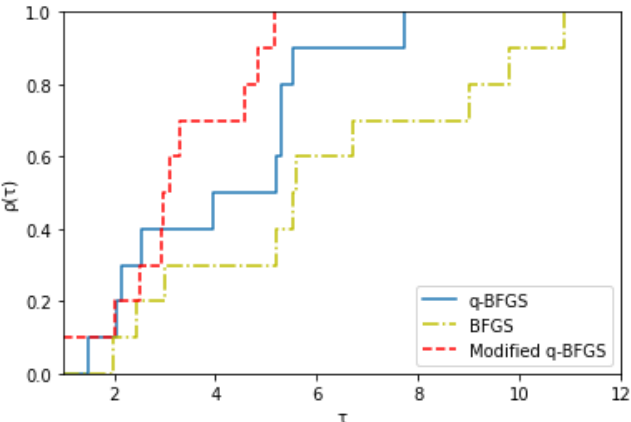
Figure 4. Performance profile based on number of function evaluations. The global minima and plotting points of the Rosenbrock function using the modified q-BFGS algorithm can also be observed in Figure 5.